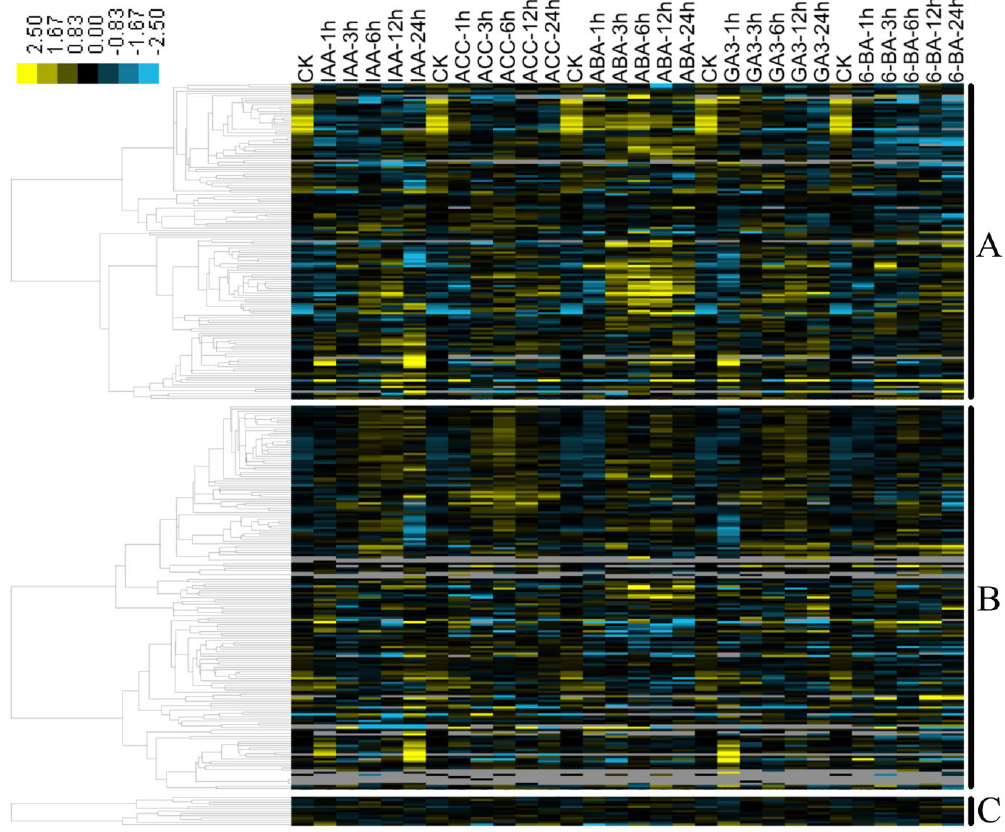
Figure 4. Transcript profiles of members of the B. napus MYB superfamily in seedling roots under individual treatments with auxin (IAA), gibberellin (GA 3 ), cytokinin (6-BA), abscisic acid (ABA) and ethylene (ACC) in a time-course manner. (A – C) Expression patterns of 141 Bn2R-MYB ( A ), 171 BnMYBR ( B ) and 12 Bn3R-MYB ( C ) genes in roots of B. napus seedlings under the IAA, ACC, ABA, GA 3 and 6-BA treatments. Transcript data were obtained by RNA-Seq. Log 2 (FPKM ≥ 1) values were displayed according to the color bar (top left). BnMYB s with no or weak expression (FPKM < 1) in all samples were excluded from this figure. Expression values of all BnMYB s under hormone treatments are supplied in Table S5. CK, control (non-treatment at 0 h).